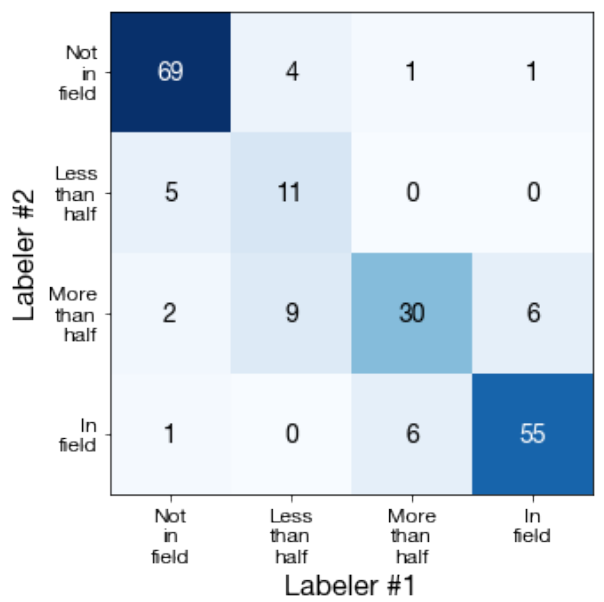
Figure A4. Labeler agreement. Confusion matrix of in-field labels generated by two labelers on a subsample of 200 DigitalGlobe images. Percent agreement across 4 classes is 83%, and across 2 classes (more than half, less than half) is 93%.